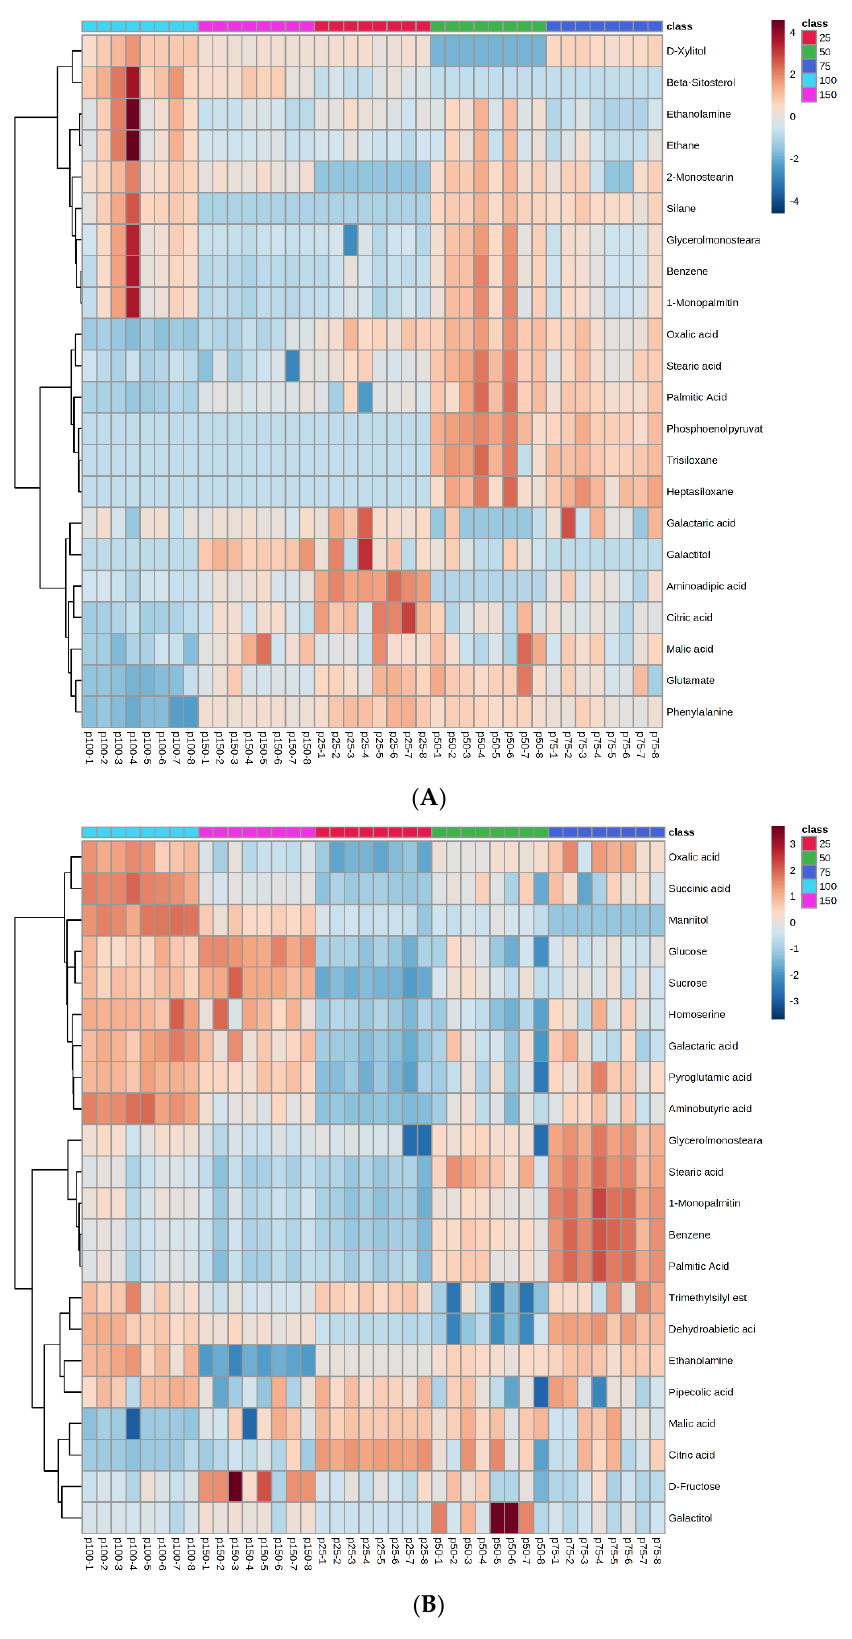
Figure 3. Correlation heat maps of differential metabolites between xylem and phloem sap of Cucumber under different phosphorus levels (xylem ( A ), phloem ( B )).